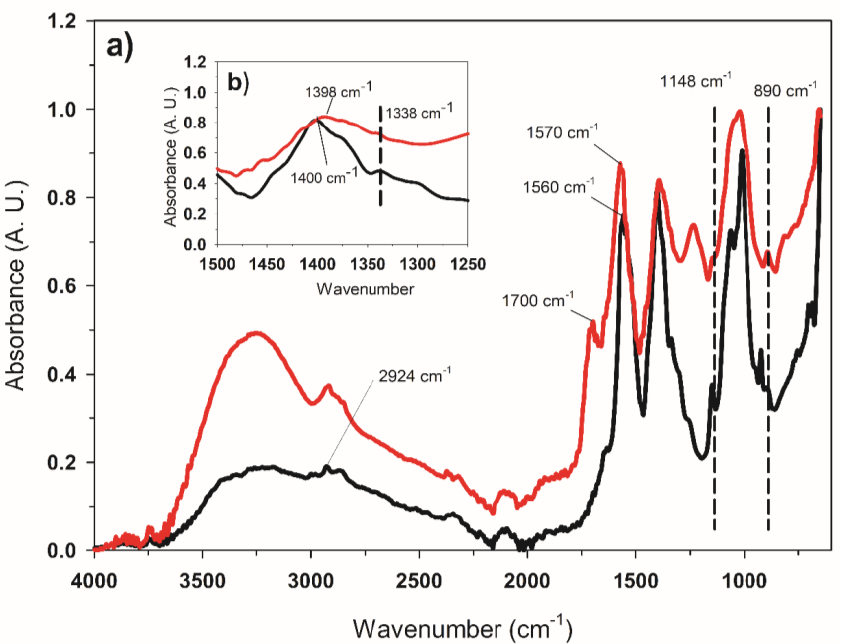
Figure 2. FTIR spectra of a ) CC ( ─ ) and UC ( ─ ) in the range between 4000 cm − 1 and 500 cm − 1 , b ) of CC ( ─ ) and UC ( ─ ) in the range between 1500 cm − 1 and 1250 cm − 1 .